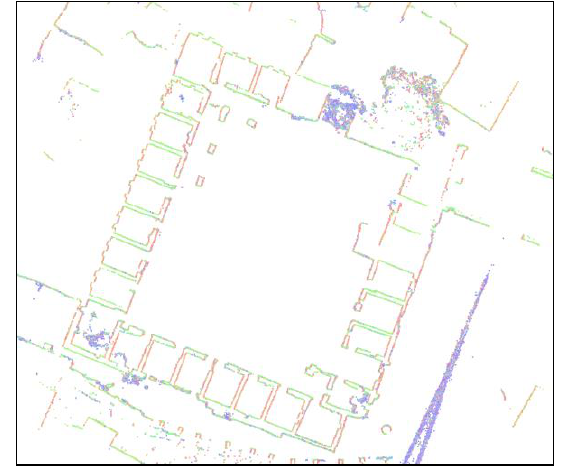
Figure 11. Floor plan section of the ground floor made in Revit